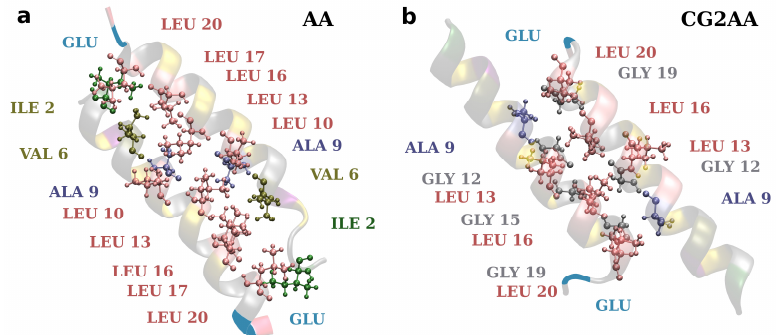
Figure 10. Representations of hydrophobic contacts in two-peptide association. The snapshot on the left is from the AA-2 simulation and depicts dimer contacts when it is electrostatically bonded to the membrane surface (corresponding to Figure 5a). The snapshot on the right is from the CG2AA simulation representing contacts when the dimer is deeper in the membrane (corresponds to Figure 5b). The distance between the peptide axis is smaller (~0.75 nm) in case ( b ) than in case ( a ) (~0.90 nm). Ribbon models with colored amino acids depict the peptides, and amino acids participating in hydrophobic contacts are specified. The Glu is also added to depict dimer antiparallel configuration. The criterion for hydrophobic contact is that any atom from one residue is within 0.35 nm of any atom in another